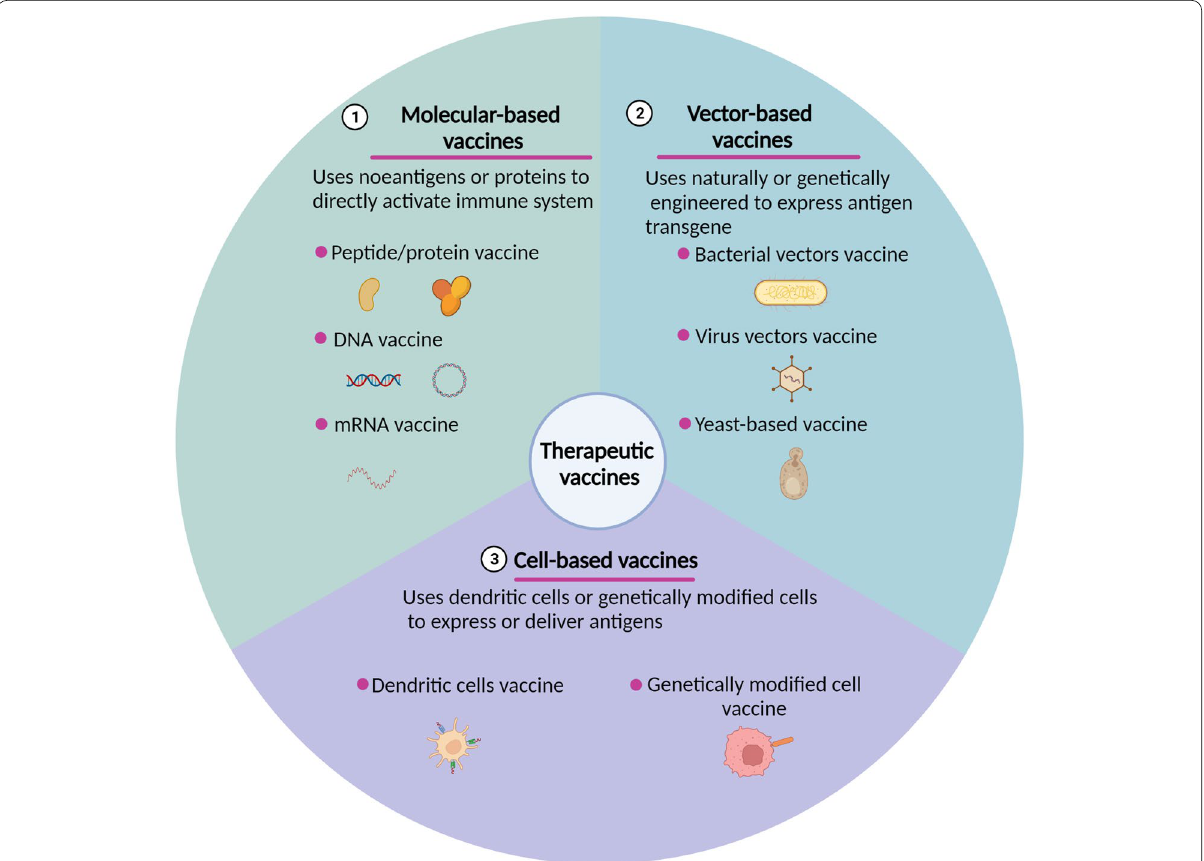
Fig. 2 An overview of therapeutic vaccine types in preclinical and clinical trials. Therapeutic vaccines have several types used in preclinical and clinical phase including molecular-based vaccines (peptide/protein vaccine, DNA and mRNA vaccine), vector-based vaccines (bacterial vectors vaccine, viral vectors vaccine and yeast-based vaccines) and cell-based vaccines (dendritic cells vaccines and genetically modified cell